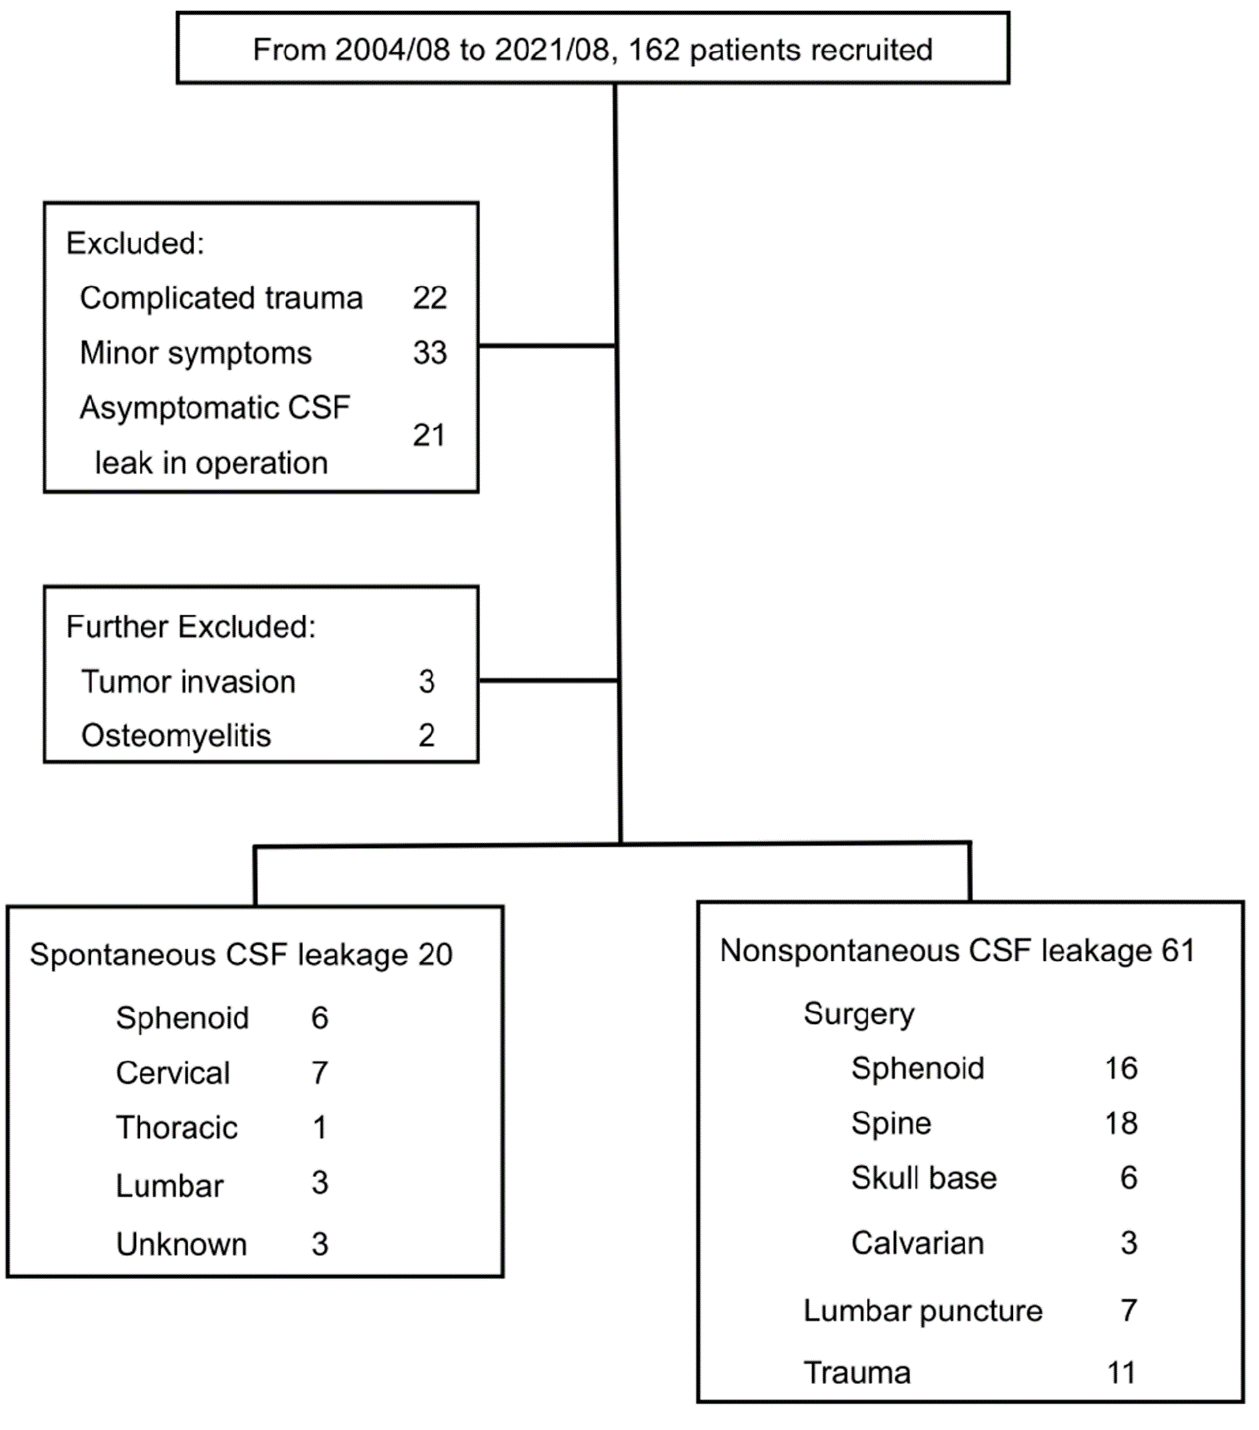
Figure 1. Study algorithm. The average age was 43.2 ± 13.8 and the gender ratio was 44:37 (female:male). We divided patients into two groups based on the spontaneity of leak (Table 1). The spon- taneous CSF leak group had 20 patients and the nonspontaneous CSF leak group had 61 patients. There were no differences in the demographic data, including age,